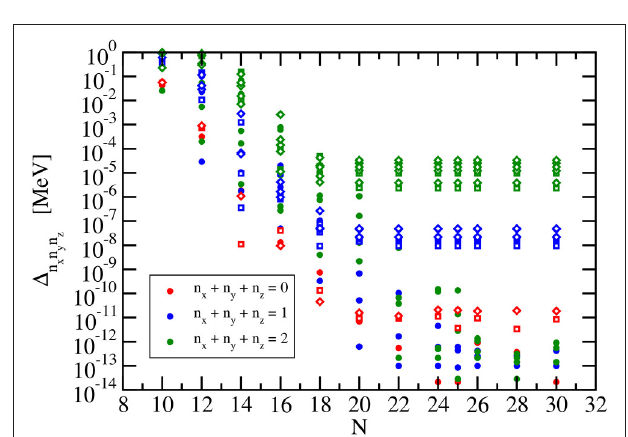
0 in a spherically = h ω 20 MeV and = ¯ 25). The normalization factor C is =